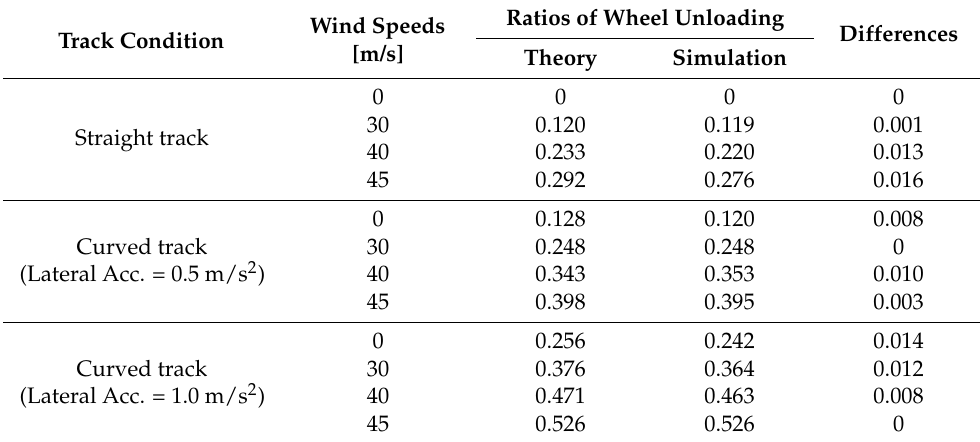
Table 10. The ratio of wheel unloading ( ∆ Q/Q) between the theoretical formula and the simulation for cross-winds.